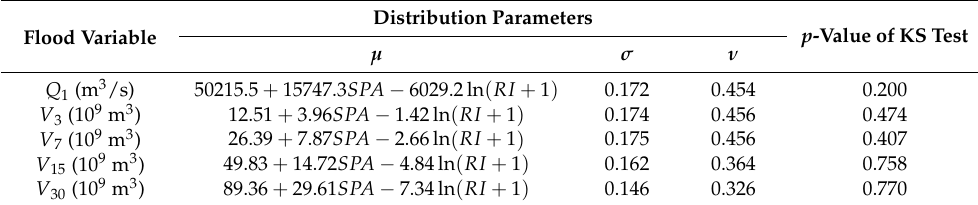
Table 2. Results of the covariate analysis for the dam-site floods of the TGR. Flood